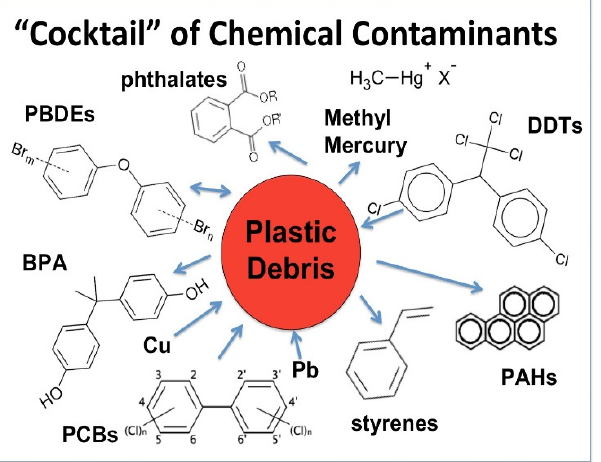
Figure 3. Toxic ingredients in microplastics (Reprinted with permission from The Ocean Foundation and Earth-DECK.org).